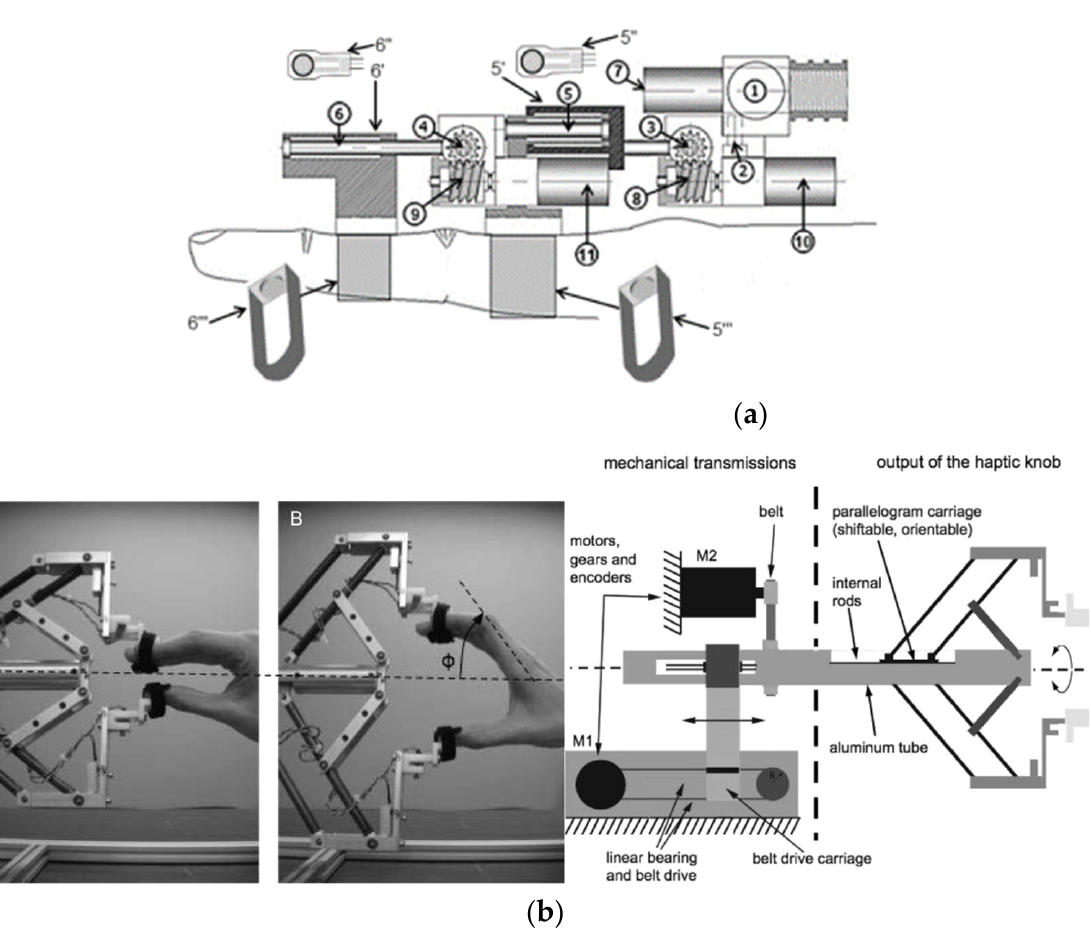
Figure 4. Mechanical designs for an exoskeleton and end-effector device. ( a ) the mechanical design of the ExoK’ab exoskeleton device ( b ) the mechanical design of the HapticKnob end-effector device [42,43].